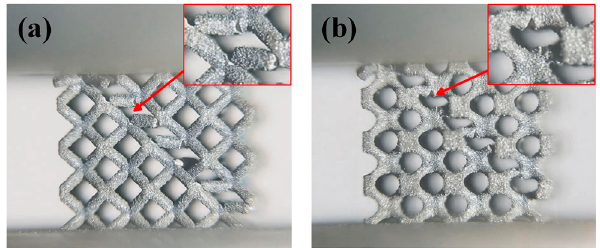
Figure 9. The fracture area of ( a ) CAD ‐ based BCC lattice structures and ( b ) TPMS ‐ based BCC lattice structures.